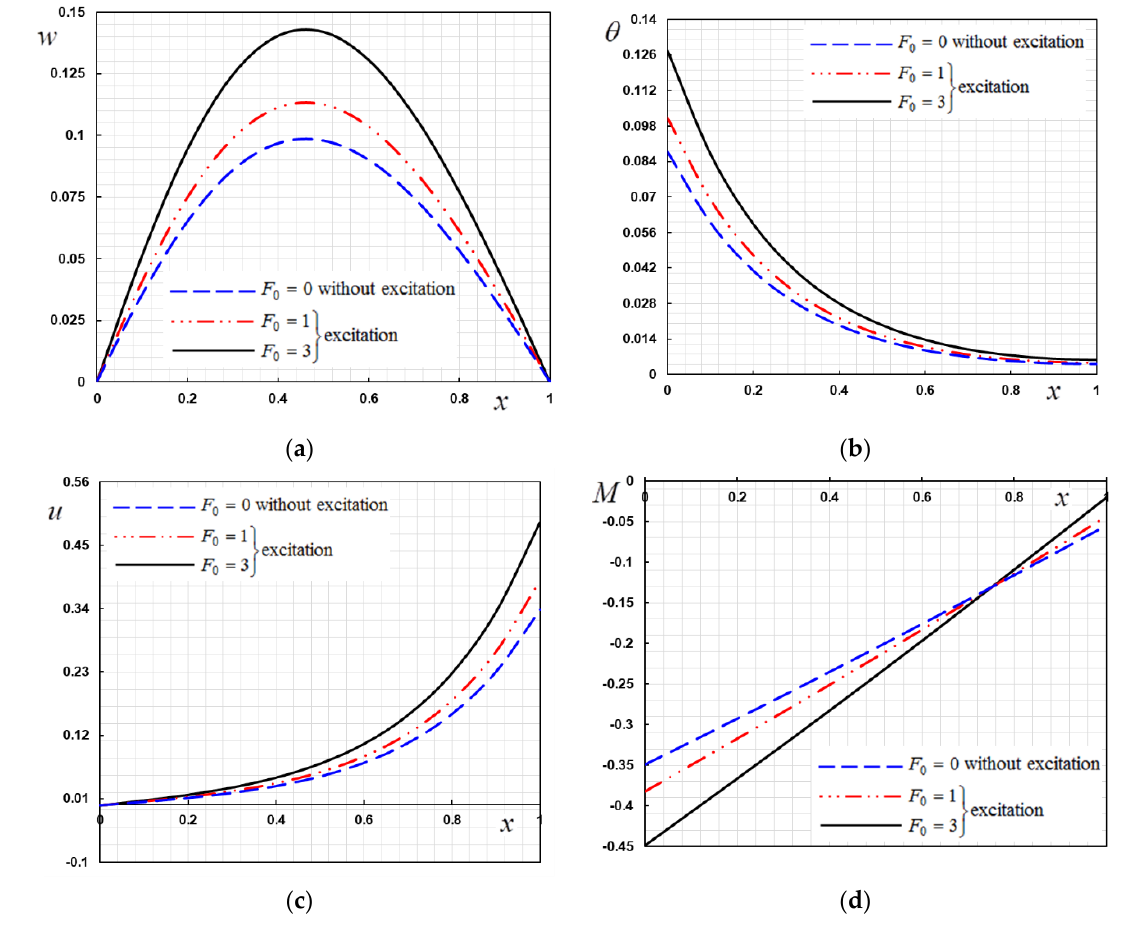
Figure 3. ( a ): The deflection w for different magnitudes of the forcing excitation 𝐹 0 . ( b ): The Figure 3. ( a ) The deflection w for di ff erent magnitudes of the forcing excitation F 0 . ( b ): The temperature ff erent magnitudes temperature θ for different magnitudes of the forcing excitation 𝐹 0 ( c ): The displacement u for θ for di ff erent magnitudes of the forcing excitation F 0 ( c ): The displacement u for di different magnitudes of the forcing excitation 𝐹 0 . ( d ): The bending moment 𝑀 for different of the forcing excitation F 0 . ( d ): The bending moment M for di ff erent magnitudes of the forcing magnitudes of the forcing excitation 𝐹 0 . excitation F